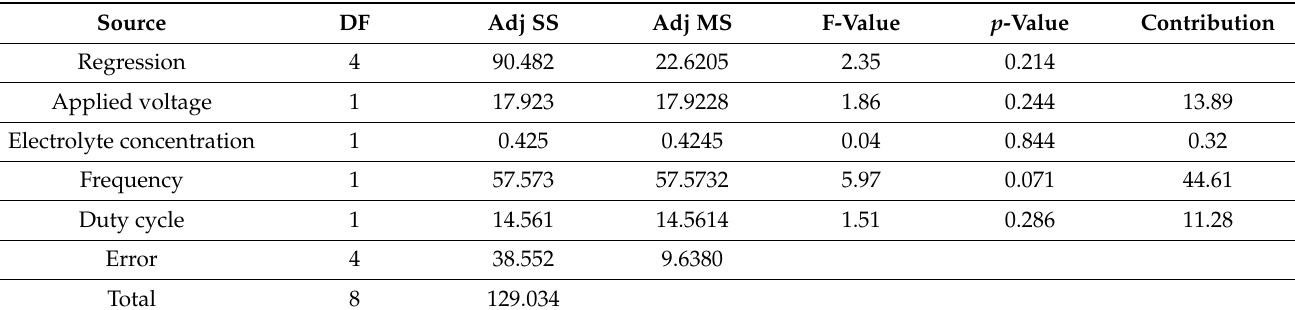
Table 8. ANOVA of MRR for annealed tool.